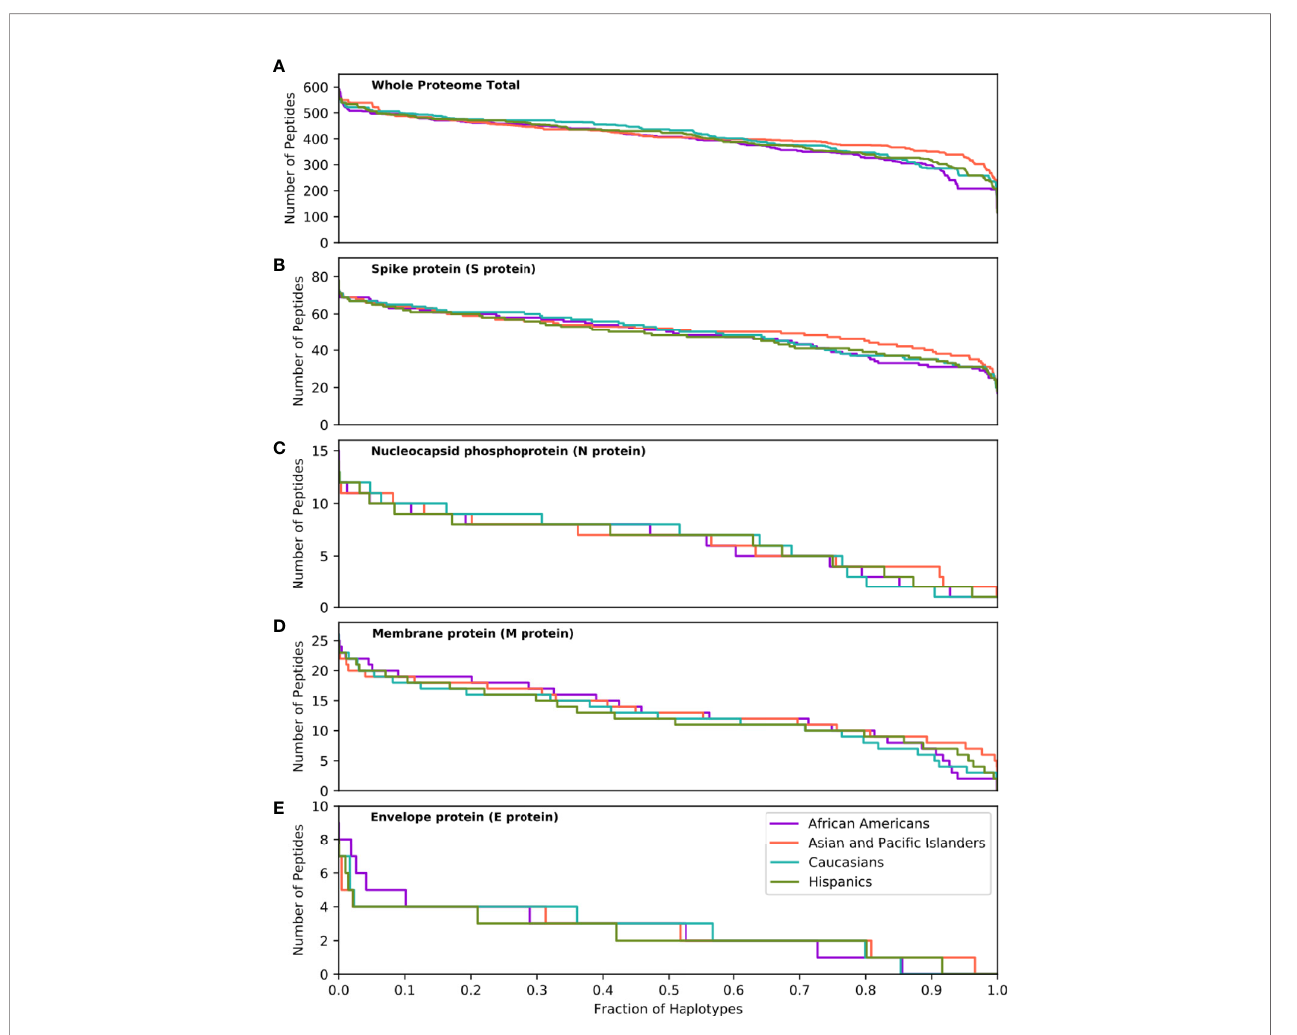
FIGURE 2 | SARS-CoV-2 derived peptide presentation at the HLA haplotype level. Panels depict SARS-CoV-2 peptide presentation by HLA class II haplotypes representing 99% of total haplotypes within four broad population groups (African Americans, Asian Paci fi c Islanders, Caucasians and Hispanics). (A) Whole Proteome. (B) Spike protein (S protein). (C) Nucleocapsid protein (N protein). (D) Membrane protein (M protein). (E) Envelope protein (E protein). The width of each step in the curves is proportional to the relative frequency of a speci fi c HLA